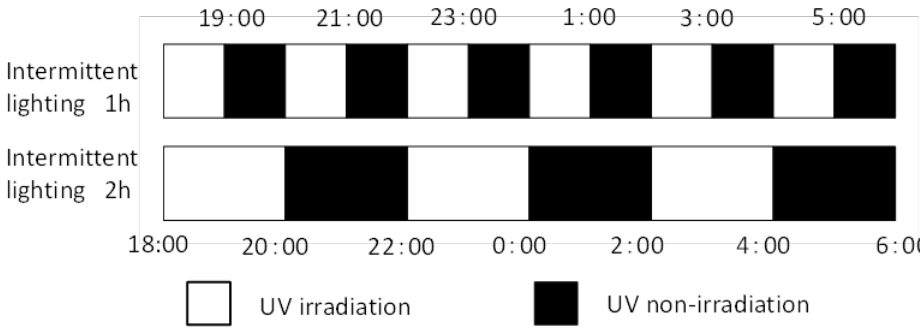
Figure 11. Timing of intermittent UV-B irradiation. White and black bars represent irradiation and non-irradiation by UV-B lamps, respectively. Intermittent UV-B irradiation was conducted for 1 h or 2 h at an interval of 1 or 2 h for 6 h, 18:00 to 6:00. The UV-B radiation intensity at the canopy level was set to 0.05 or 0.1 W m − 2 by adjusting the distance from the light source to each plant material.